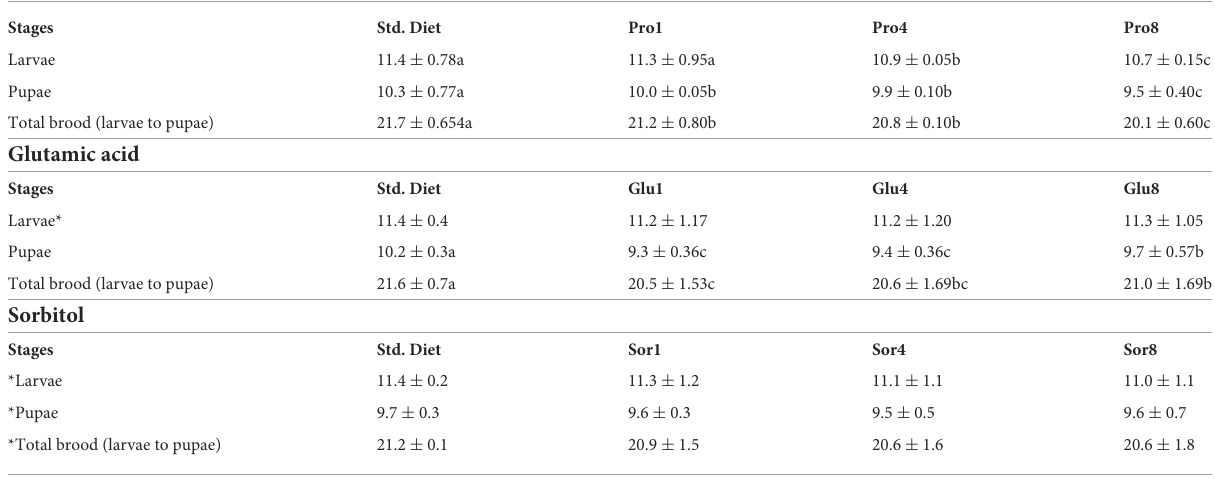
TABLE 2 The effects of different concentrations of proline, glutamic acid, and sorbitol (1, 4 and, 8%) supplementation on the development of bee brood (days ± S.E) and standard diets fed to honey bee larvae. Proline